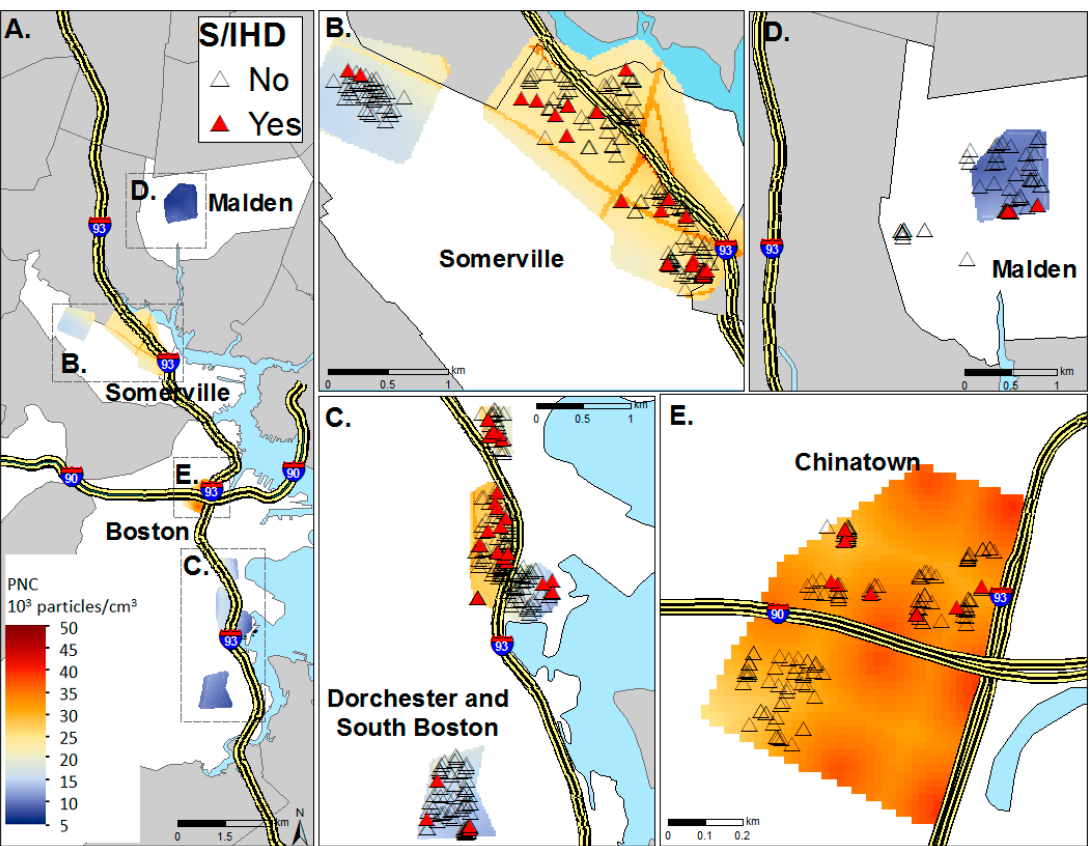
Figure 1. CAFEH study populations by status of stroke and ischemic heart diseases (S/IHD) in the neighborhoods of Somerville, Dorchester/South Boston, and Chinatown/Malden. ( A ) All study areas with annual average TAA-PNC levels; ( B ) The Somerville near highway and urban background study areas with participants by stroke/ischemic heart disease status (S/IHD); ( C ) Dorchester and South Boston near highway and urban background study areas with participants by S/IHD status; ( D ) The Malden (urban background for Chinatown) study area with participants by S/IHD status; ( E ) The Chinatown near highway study area with participants by S/IHD status.